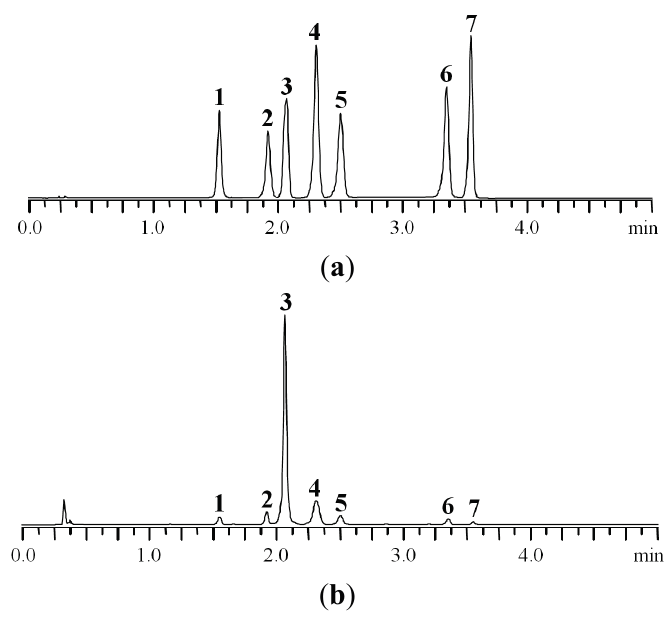
Figure 2. MC-RP-HPLC-UV chromatograms of standard mixture ( a ) and P. anserina extract ( b ) detected at 270 nm. 1 . caffeic acid; 2 . myricetin-3- O -glucuronide; 3 . agrimoniin; 4 . ellagic acid; 5 . miquelianin; 6 . isorhamnetin-3- O -glucuronide; 7 . kaempferol-3- O -rhamnoside.